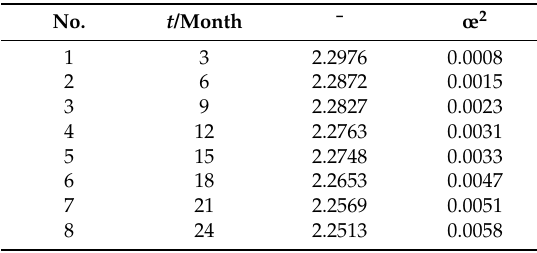
Table 3. Characteristic parameters of